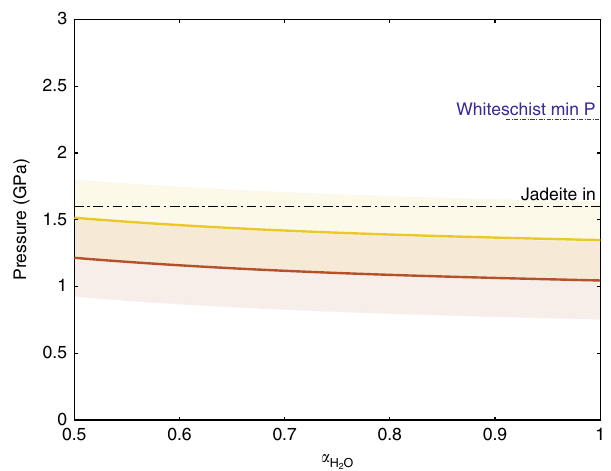
Fig. 5 Effect of a reduction of H 2 O activity on pressure for two fi xed phengite silica contents of 3.42 Si p.f.u (red line) and 3.54 Si p.f.u (yellow line) assuming a constant temperature of 550°C. Calculations and error envelopes (red and yellow fi elds, respectively) are based on experimental data 26,27 . The blue dashed line corresponds to the minimum peak-pressure estimate for the whiteschist (see Fig. 2a) and the black dashed line corresponds to the pressure of the jadeite in reaction 23 (calculated using Berman, 1988 database 20 ). The yellow and red curves represent the pressure estimate for the metagranite closest (yellow) and farthest (red) to insuf fi cient to provide pressure estimates >1.6 GPa within the